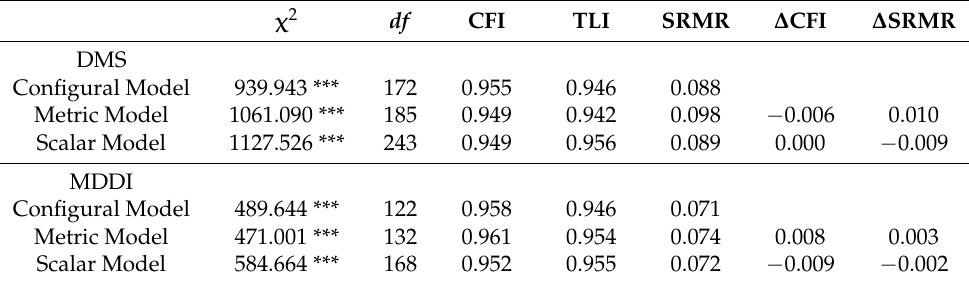
Table 4. Measurement invariance tests by samples for the DMS and